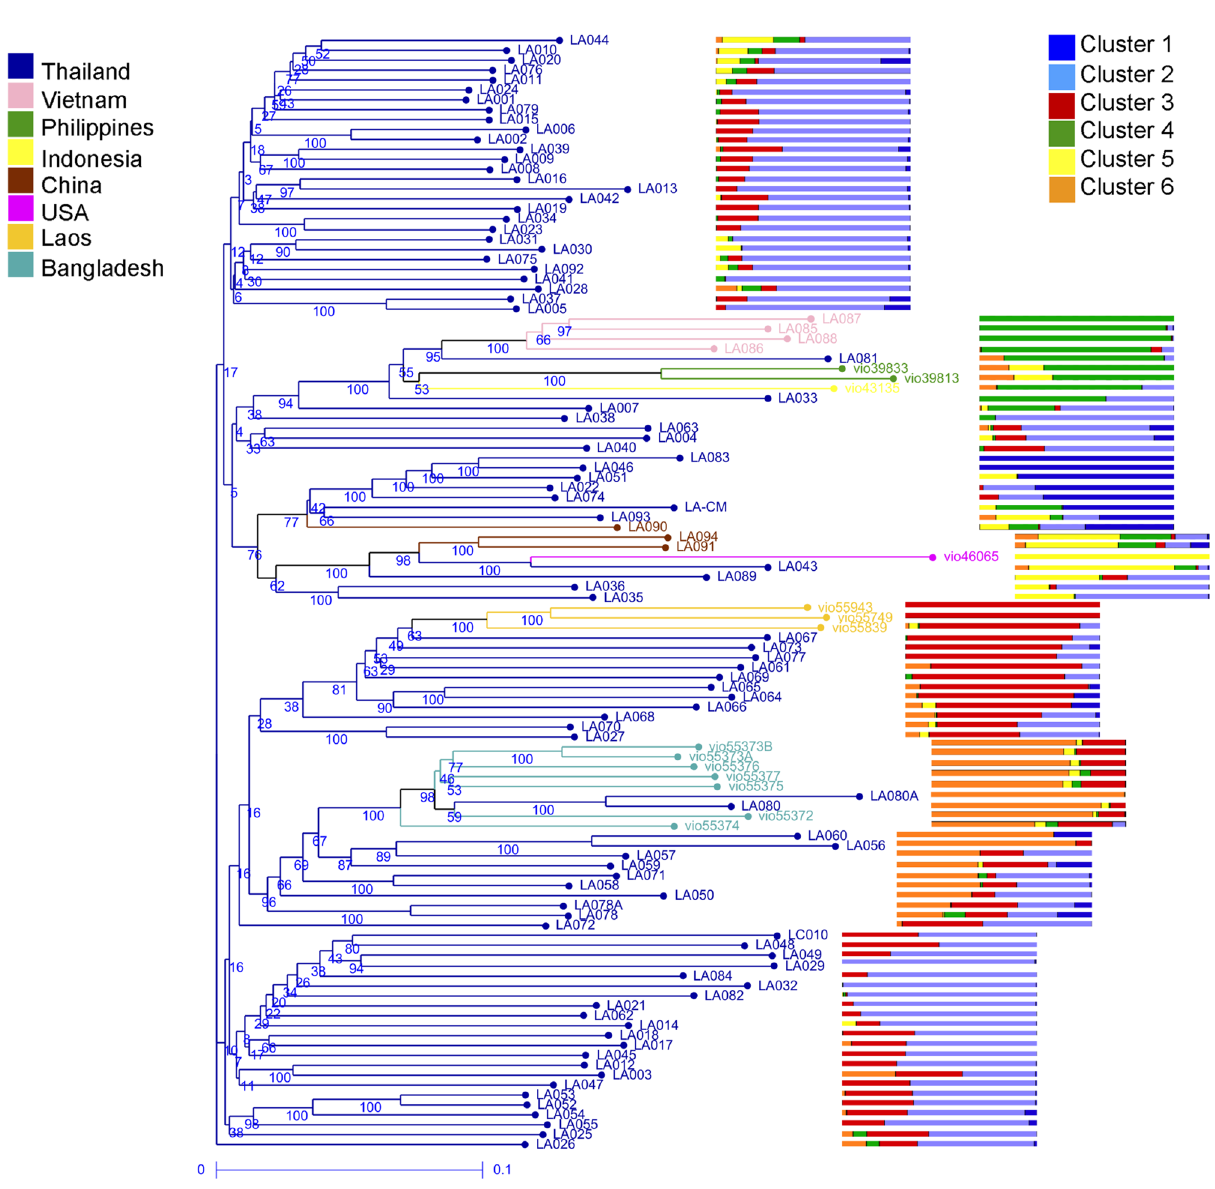
Figure 5. Genetic diversity proportion of 112 Luffa acutangula accessions based on country of origin. Branch colors indicate country of origin. Side bars correspond to proportion clustering from Fig.